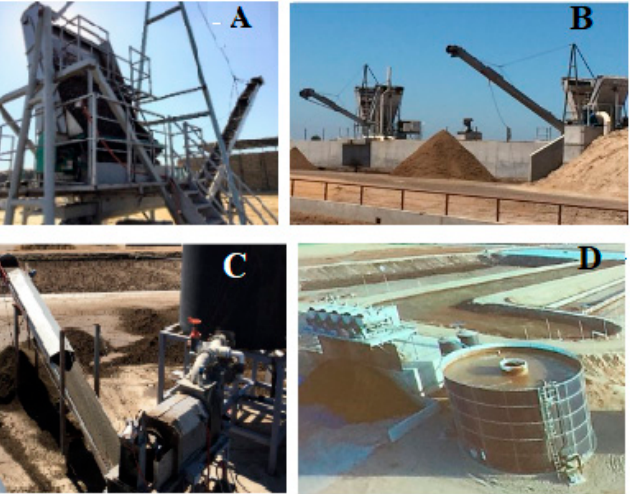
Figure 3. Mechanical separators applied in Californian dairies: ( A ) single-stage screen; ( B ) two-stage sloped-dual screen; ( C ) screw press; and ( D ) advanced multistage rotary drum. Table 1. A comparison of selected screen separators for dairy